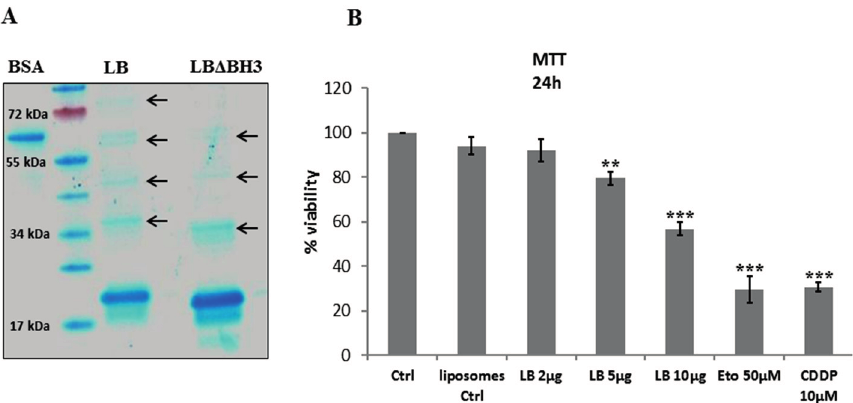
Figure 1. Bak Liposomes (LB) induce cell viability inhibition. ( A ) Coomassie Blue staining of LB and Liposomes with Bak missing the pro-apoptotic domain BH3 (LB Δ BH 3 ). Bovine serum albumin (BSA) (0.25 mg/mL) is used as reference protein. Arrows indicate protein oligomers; ( B ) MTT viability test on GL26 cells treated for 24 h with increasing doses of LB. Histograms represent the average ± standard deviation (S.D.) of 5 experiments. Ctrl: untreated cells; liposomes Ctrl: cells treated with empty liposomes; Eto: etoposide; CDDP: cisplatin. ** p < 0.01 and *** p < 0.001 vs.